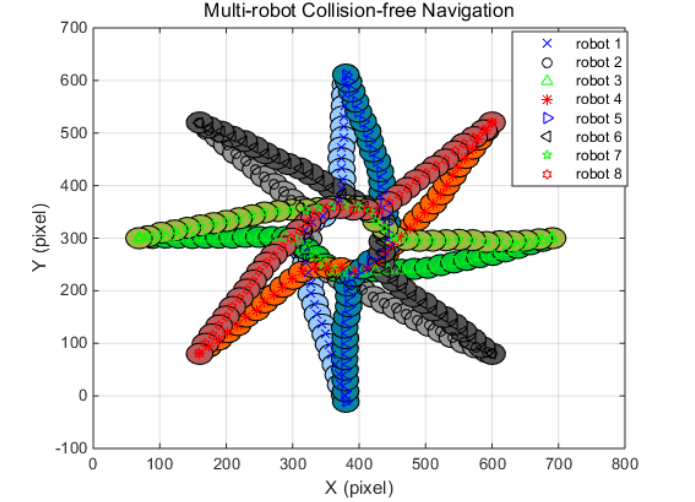
Figure 9. FAHP-CGT algorithm for eight-robot navigation.